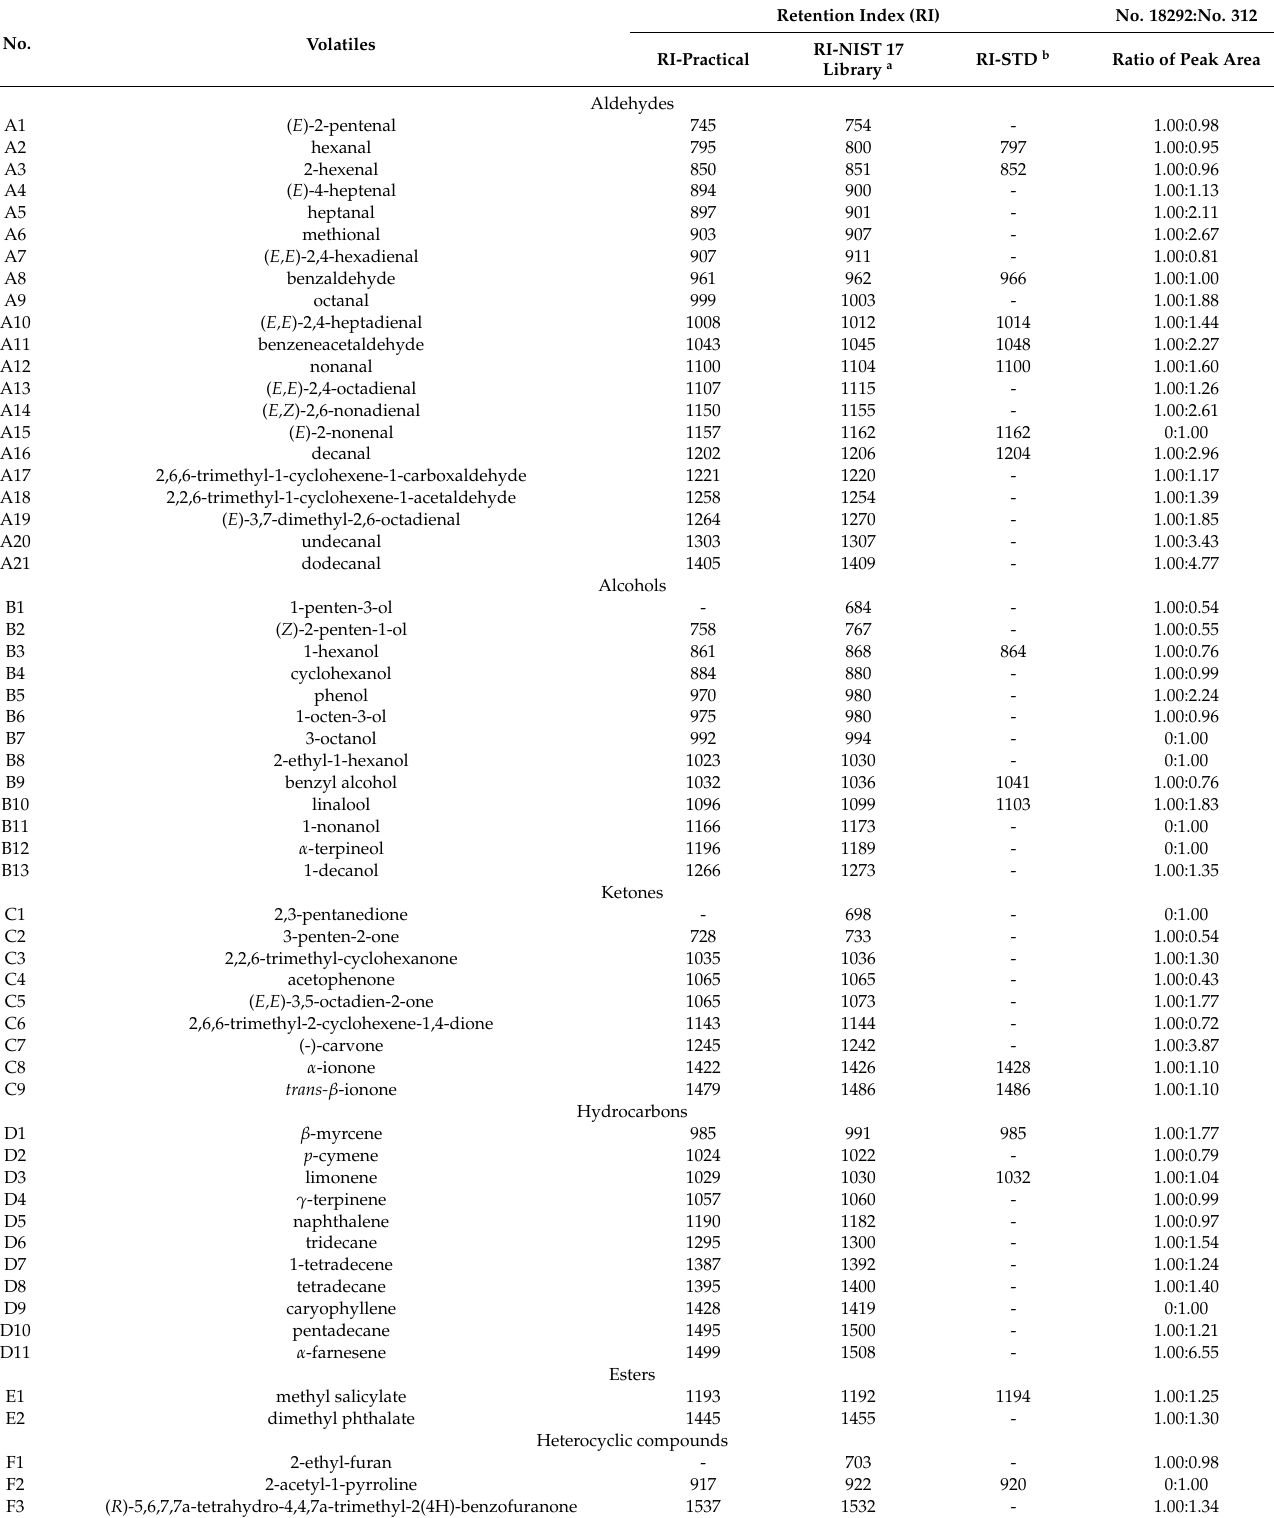
Table 1. Volatiles identified in the leaves of pumpkin sample No. 312 with ‘taro-like’ aroma and sample No. 18292 without ‘taro-like’